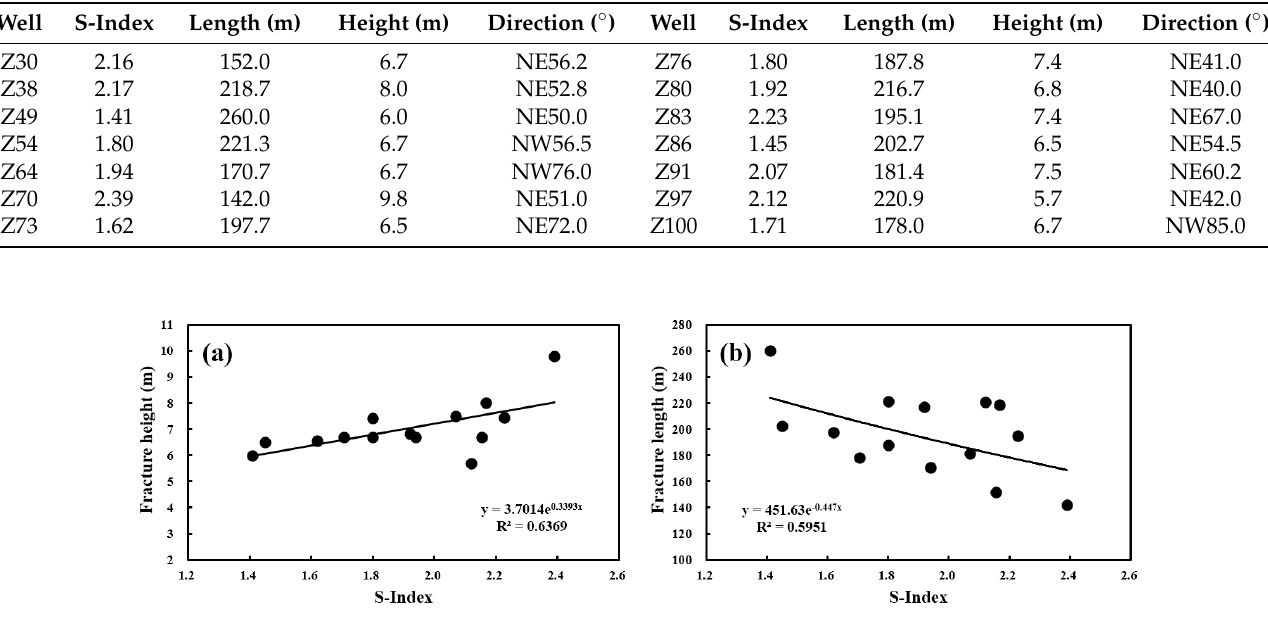
Figure 11. Relationship between S-Index and fracturing efficiency. ( a ) Relationship between S-Index and fracture height. ( b ) Relationship between S-Index and fracture length.